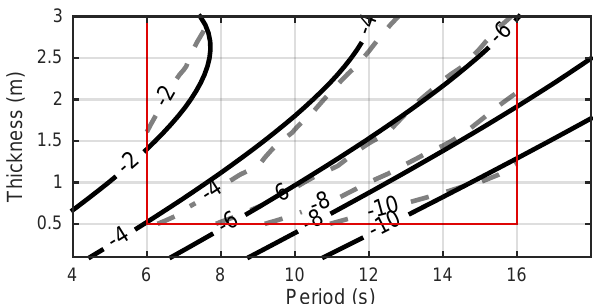
Figure 2. The natural logarithm of the attenuation coefficient α calculated by Kohout and Meylan (2008) (dashes, inside the red box) and a quadratic fit to this attenuation coefficient that is used in Sect. 2.3 (solid lines). Solid contours outside of the red box are extrapolated using the quadratic fit. The fit is given by ln α(T, ¯ h) = − 0 . 3203 + 2 . 058 ¯ h − 0 . 9375 T − 0 . 4269 ¯ h 2 + 0 . 1566 ¯ hT + 0 . 0006 T 2